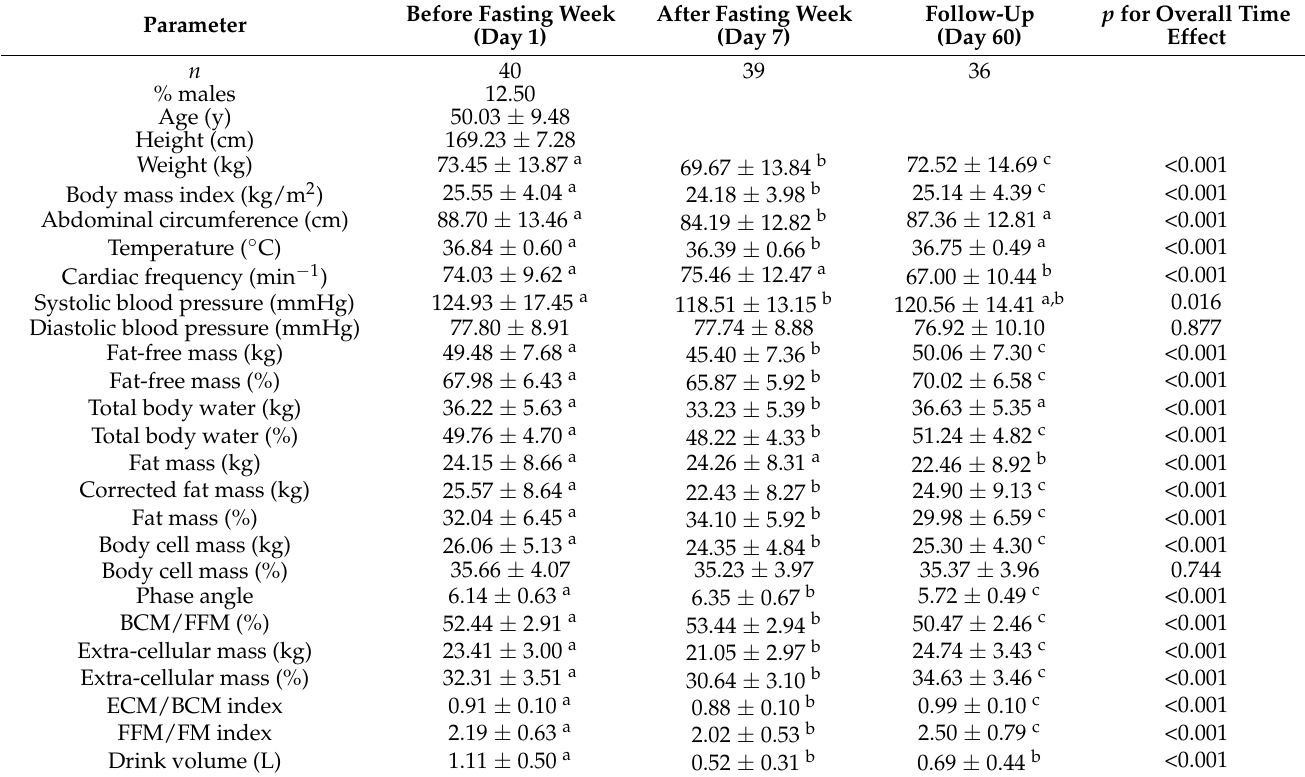
Table 2. Anthropometric parameters, clinical parameters and body composition at fasting week completion (Day 7) and at a 2-month follow-up (Day 60) in n = 40 generally healthy